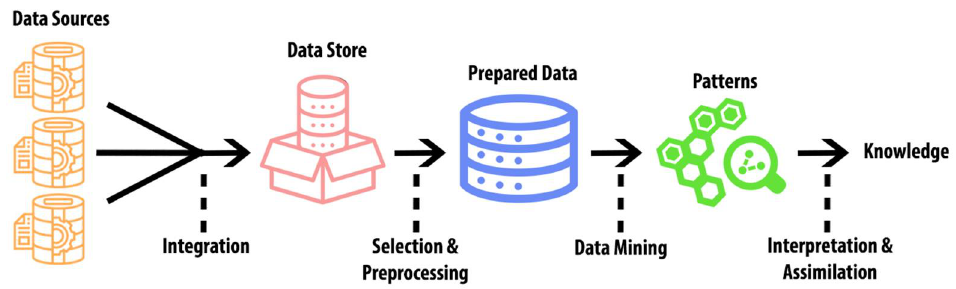
Figure 2. The knowledge discovery process according to Bramer (2007).